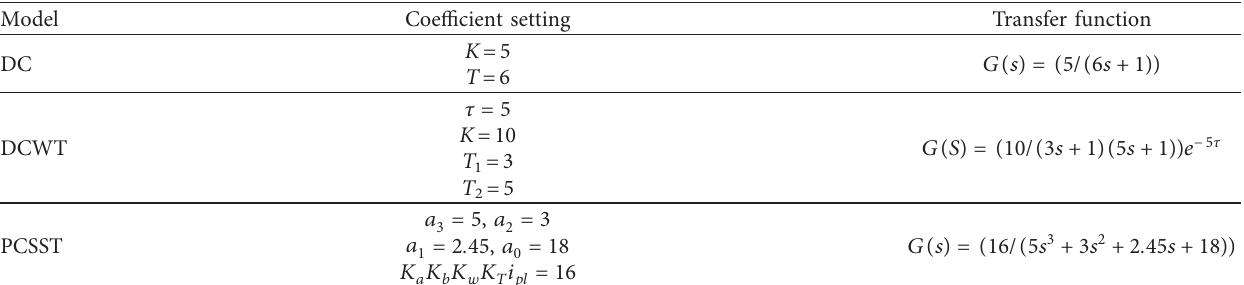
Table 3: Transfer